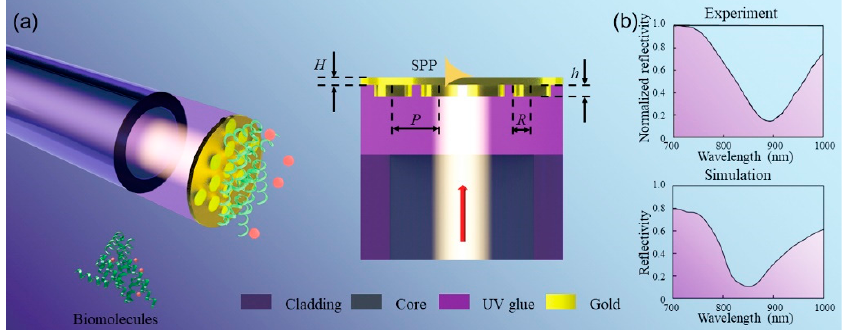
Figure 1. Schematic of the proposed nanodisk array/thin film-based fiber probe and its characteristic optical spectra. ( a ) Its three-dimensional drawing and cross-section clearly demonstrate the plasmonic coupled nanostructure of Au nanodisk array/thin film integrated on the fiber end face by UV curing adhesive, where the planar Au film resides on the top surface of the fiber probe. The corresponding structural parameters and the propagation direction of incident light (red arrow) are also indicated in ( a ). ( b ) Measured and simulated reflection spectra of nanodisk array/thin film-based fiber probe immersed in a pure water solution.